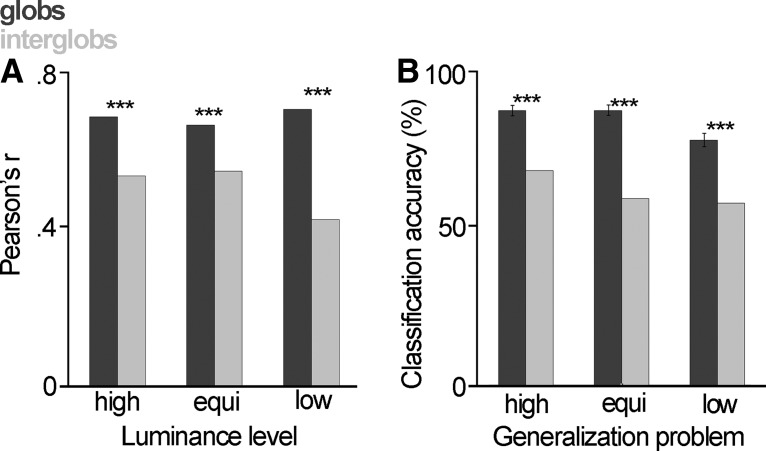
Neural color space and CIELUV hue RSA (A) and hue decoding (B). A, Neural distances between stimuli are significantly correlated with the hue angle distances between these stimuli in perceptual CIELUV color space. Both glob and interglob population representations are significantly correlated with CIELUV for the high-luminance, equiluminant, and low-luminance stimulus sets (p < 0.0001, t test, two-tailed). For all sets, the glob representations are significantly more correlated with CIELUV than are the interglob representations (high-luminance set: p = 2.05 × 10−8, t test two-tailed, Fisher r-to-z; equiluminant set: p = 1.70 × 10−5; low-luminance set: p < 2.0 × 10−16). B, Representations of the same hue at different luminance levels are sufficiently similar that hue information can be read out by a linear SVM invariant to changes in luminance. Mean pairwise hue classification accuracies for three generalization problems. A classifier was trained to distinguish between hues given two stimulus sets (e.g., low-luminance and equiluminant), and tested on the held-out stimulus set (e.g., high-luminance). The test luminance appears below each set of bars. Classification accuracy was significantly above chance for all generalization problems in both populations (p < 0.005, permutation test), though significantly higher for the glob than interglob population (all generalization problems: p < 0.0001, McNemar’s exact test, two-tailed). Error bars indicate the SD of the mean across 200 subsampling runs.